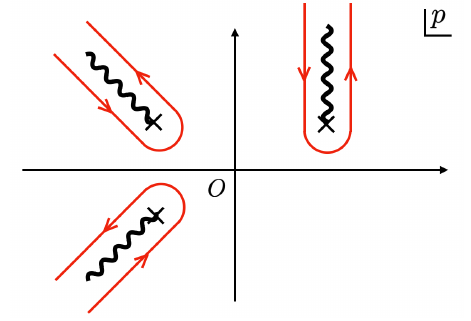
Figure 10 . Schematic diagram of the contour of p integration in eq. (C.3). Each branch cut extends to the direction in which the integral wrapping it converges.